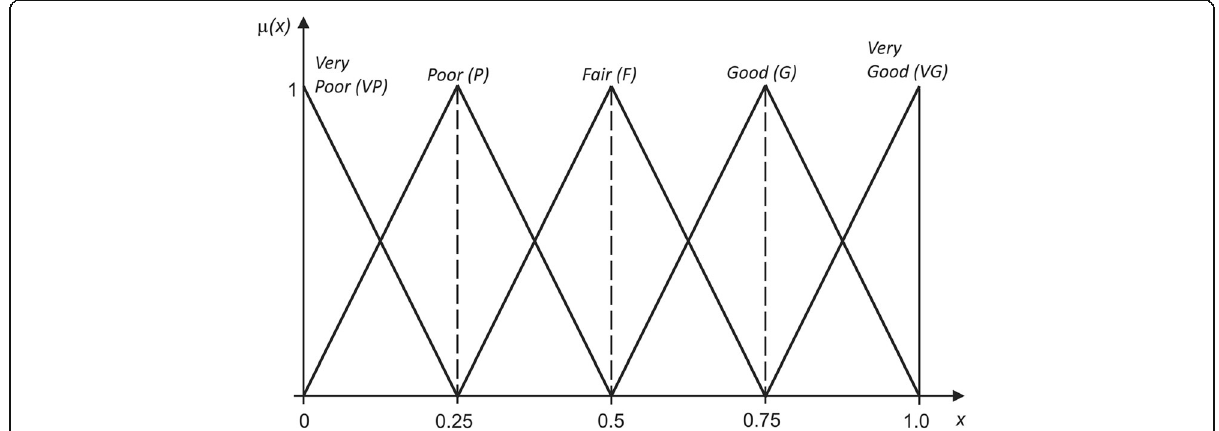
Fig. 3 Linguistic variable of alternative